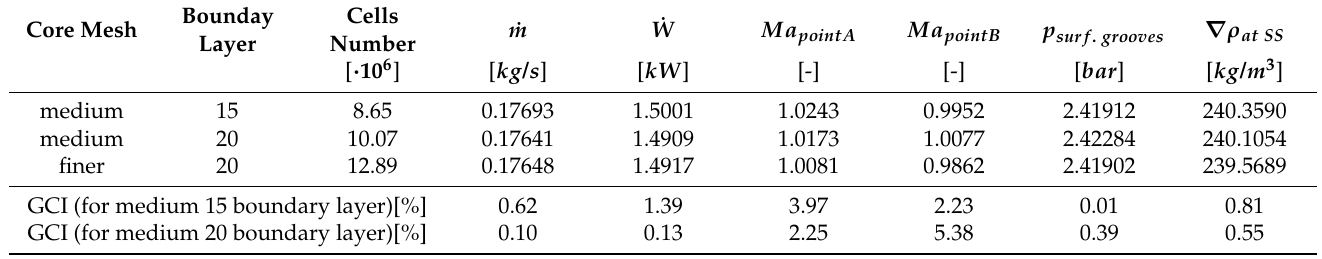
Table 3. Mesh independence study.